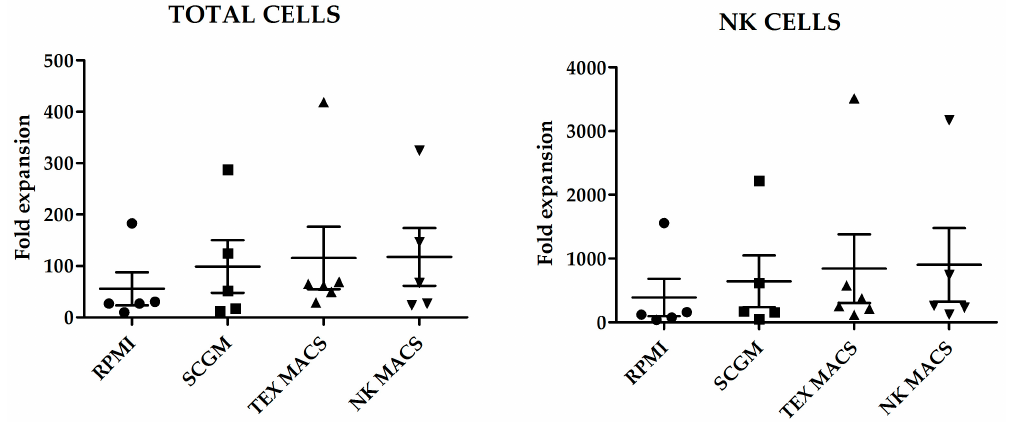
Figure 1. Fold increase of total cells and natural killer (NK) cells after the 21 days’ culture with the different media. Error bars show mean ± SEM. RPMI, SCGM and NK MACS n = 5. TexMACS n = 6. Geometrical symbols represent individual data of expanded cells from different donors by using RPMI (dots), SCGM (squares), TexMACS (triangles), NKMACS (inverted